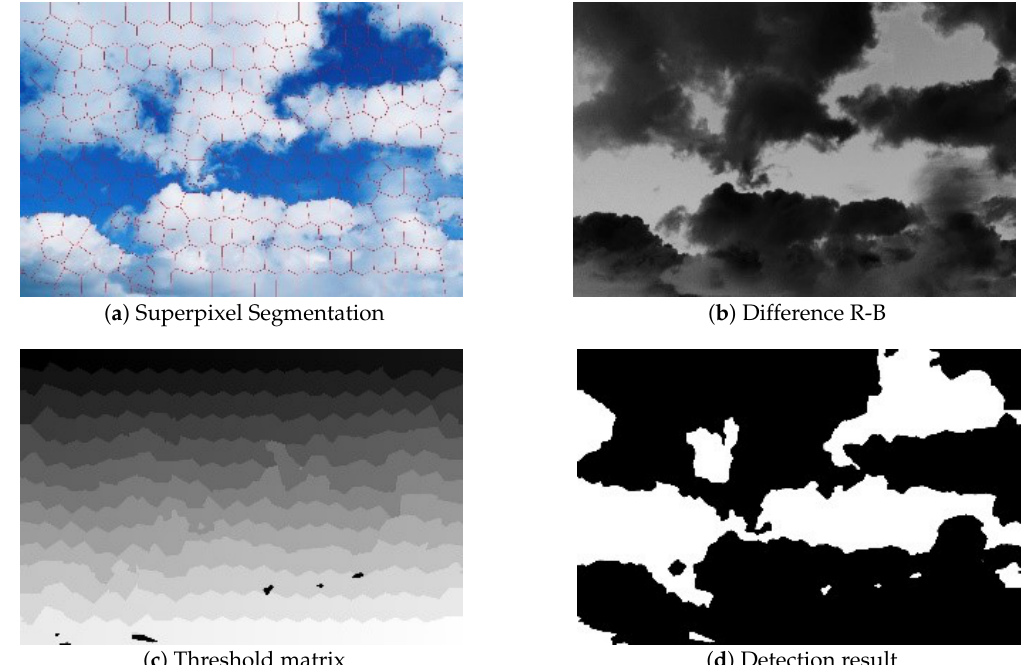
Figure 2. Steps of the algorithm described in Reference